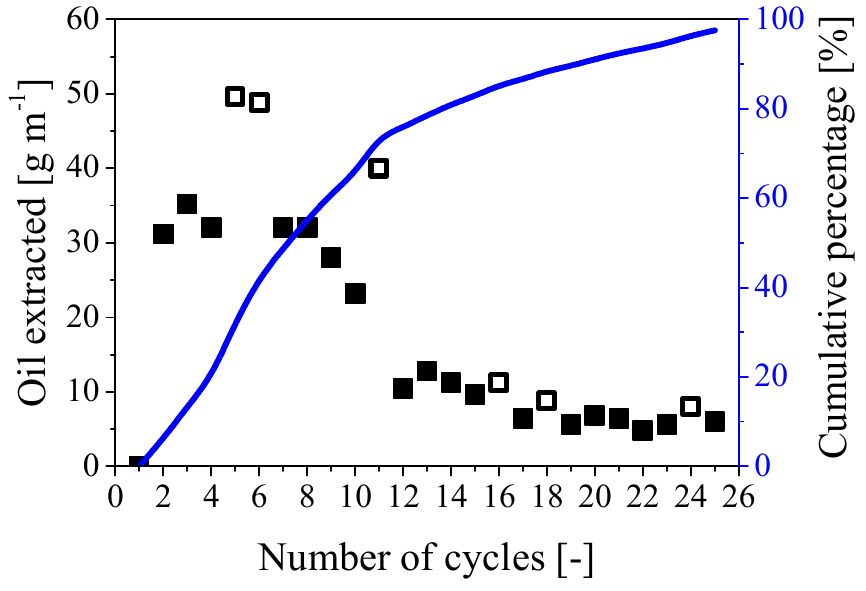
Figure 9. Amount of oil extracted during 25 repeated cycles. Symbols: mass of oil extracted per cycle; full symbols: 24/24; empty symbols: 24/48. Curve: cumulative percentage of extracted oil referred to the expected overall oil mass of 550 g m − 1 .